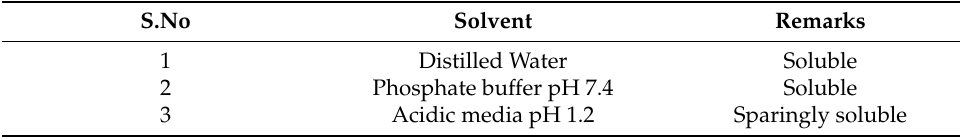
Table 1. Solubility study of 5-FU at 37 ◦ C.